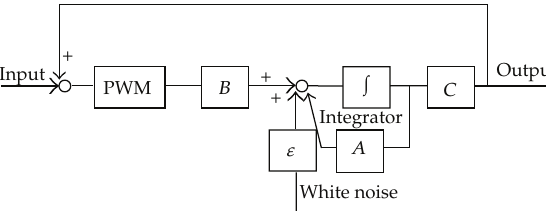
Figure 2: Block diagram of PWM feedback systems subjected to additive